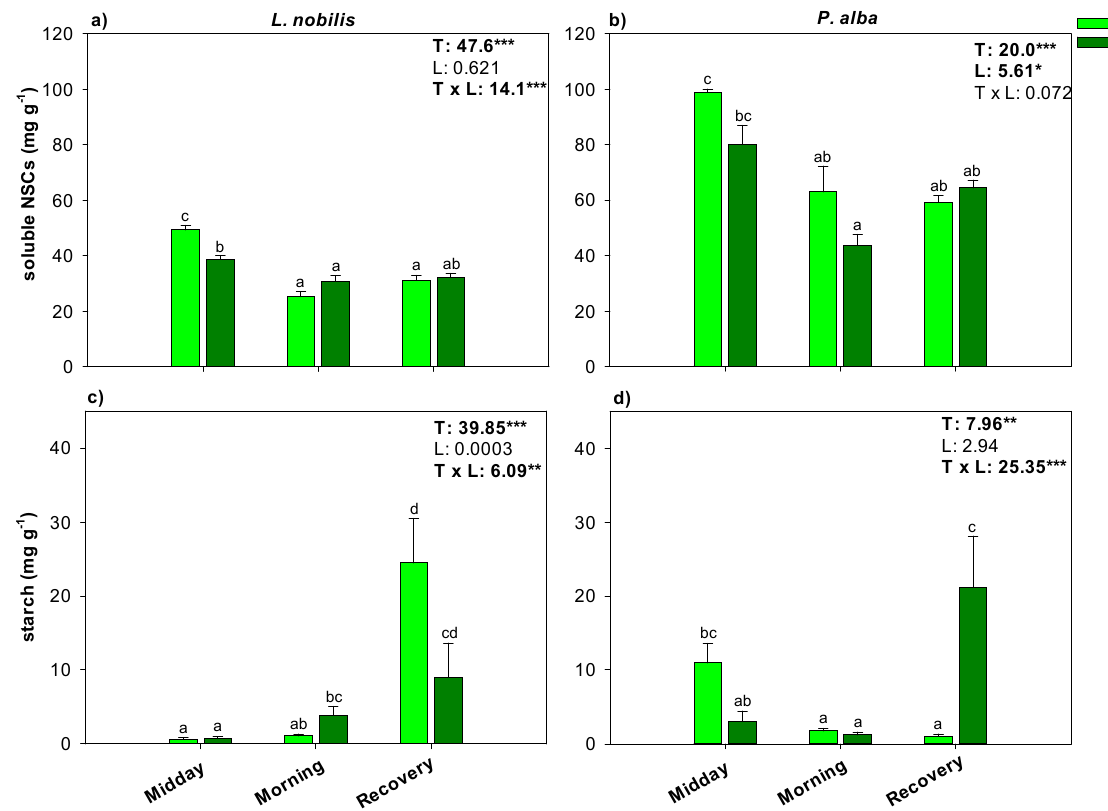
Figure 4. Mean values ± SEM of ( a , b ) soluble NSCs and ( c , d ) starch content as recorded in control (C) and shaded stem (S) samples of L. nobilis and P. alba at midday, on the following morning (Morning) and at morning after re-irrigation at field capacity (Recovery). Light and dark green columns refer to C and S samples, respectively. F values, as obtained by the two-way ANOVA analysis, are reported. Time of measurement, T, and light treatment, L (i.e., control and shaded samples) are the explanatory variables. * = p < 0.05; ** = p < 0.01; *** = p < 0.001.